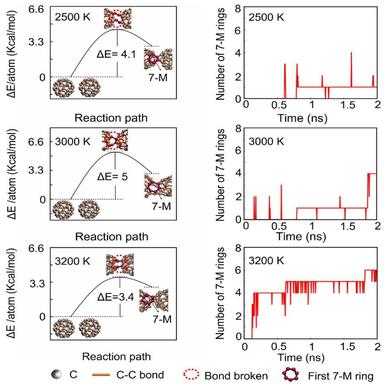
The reaction path of C60 dimers at the early stage of conversion (left) and the statistical results of 7-M rings (right) at different temperatures. (A colour version of this figure can be viewed online.)